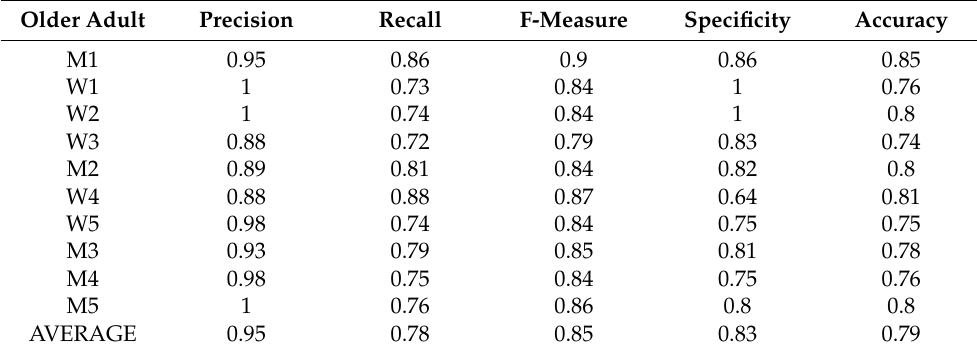
Figure 11. Example of day classified as featuring activity duration anomalies.